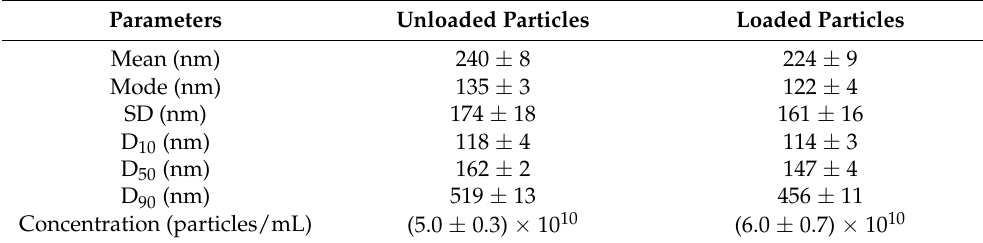
Figure 1. NTA particle size distribution analysis of unloaded and loaded systems. Representative histograms of the average size distribution (black line) from three measurements of a single sample. Red areas specify the standard deviation (SD) between measurements, and blue numbers indicate the maxima of individual peaks. Table 1. Average particle size measured by NTA, considering the unloaded and loaded systems with no added preservatives.